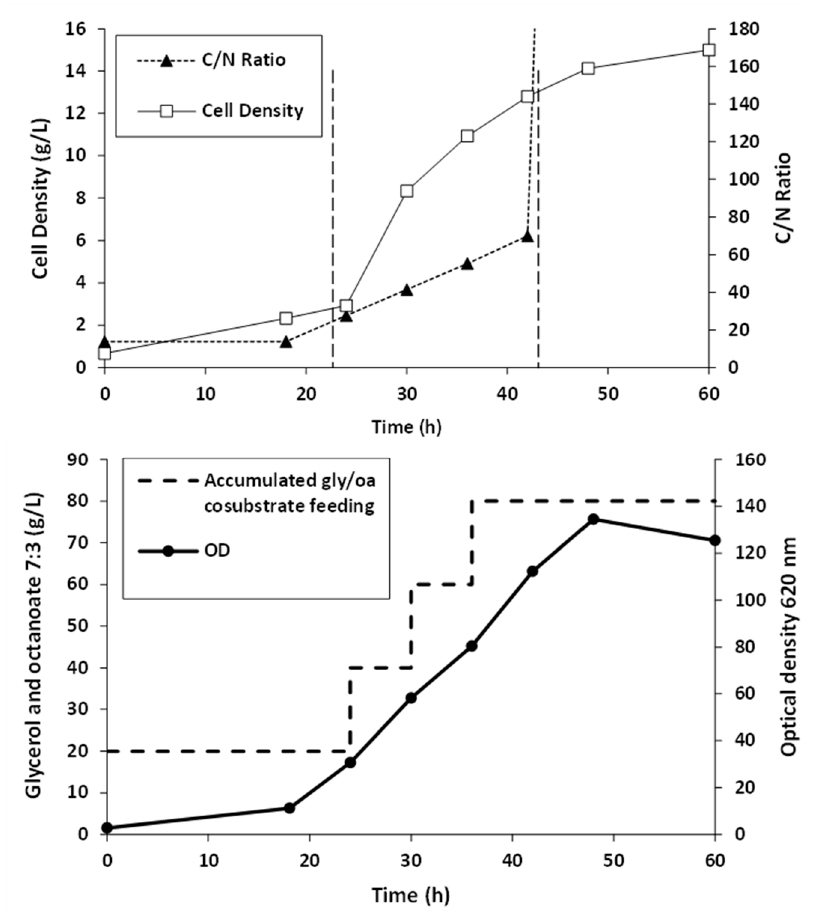
Figure 2. Time courses of MCL-PHA biosynthesis: cell growth, substrate, and nutrient control, in fed-batch of Pseudomonas putida ATCC47054 cultured by fed-batch fermentation in a 5-L bioreactor for 60 h using glycerol/octanoate co-substrates.